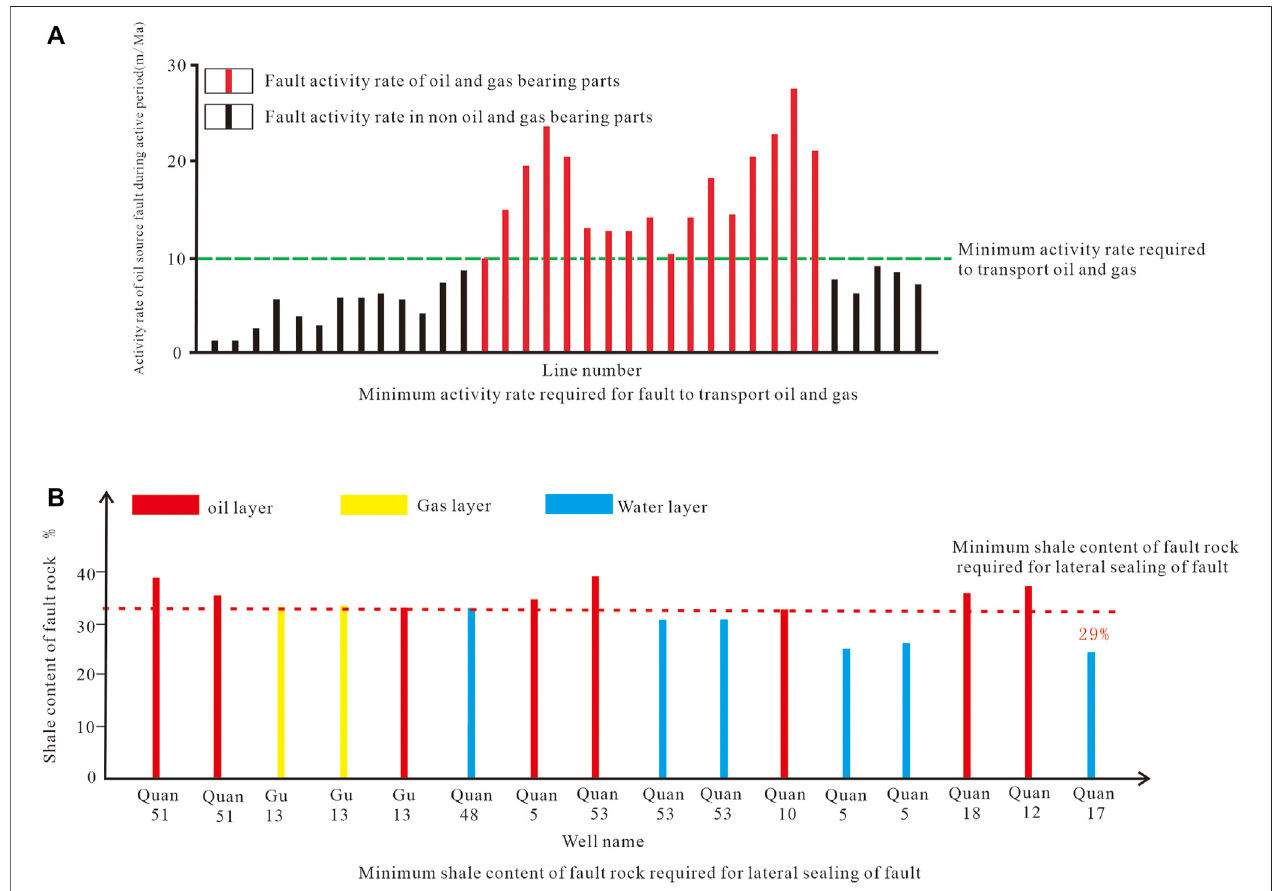
FIGURE 8 | Determination of lower limit for oil and gas transportation of faults in Daliuquan area in the middle and lower sub-member of Es3.